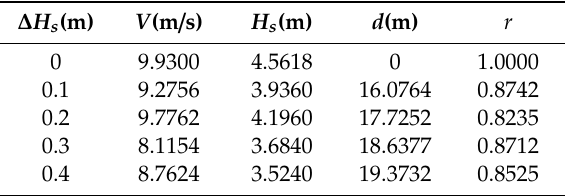
Table 7. Comparison of observation and prediction data.